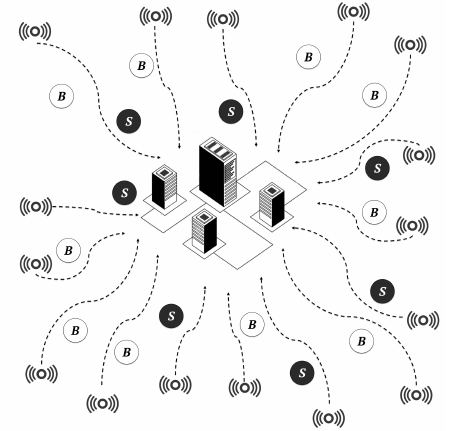
Figure 10. Cloud-only environment. This theoretical scenario is created only for comparison to cloudlet and cooperative environments. In this figure, a set of uniformly distributed sensors generate a workload composed of batch jobs B and service jobs S , which are deployed to a central data centre, composed of 500 high-end servers, with high